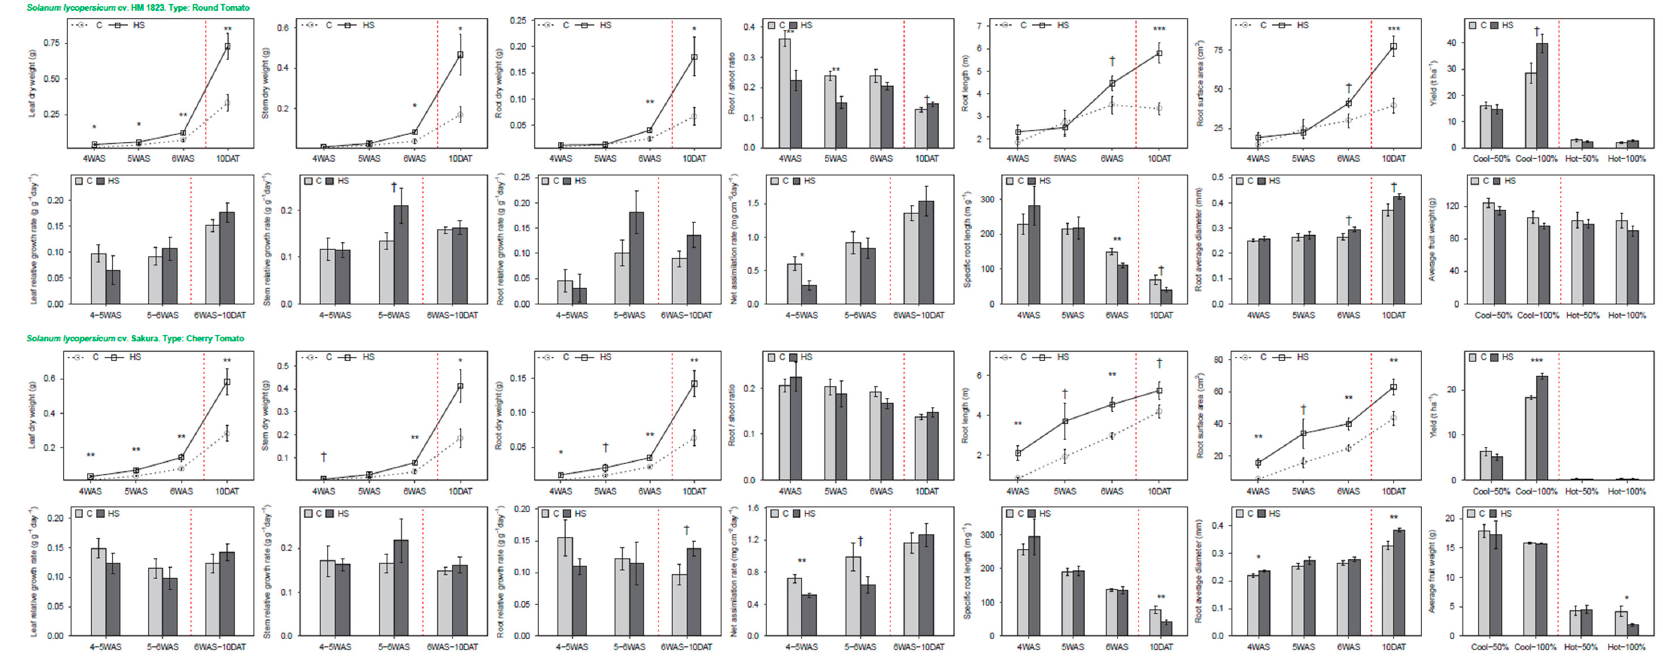
Figure 3. Tomato seedling and transplant quality traits as a ff ected by media amendments, yield traits as a ff ected by amendments and irrigation during the two growing seasons. †, *, **, *** show signi fi cant di ff erence comparing HS to control (C) at P ≤ 0.1, 0.05, 0.01, and 0.001, respectively.